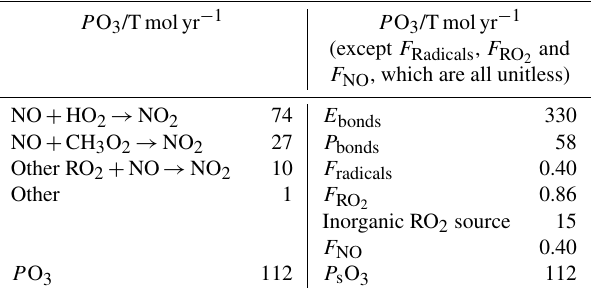
Table 1. Comparison of ozone production diagnostics for GEOS- Chem base simulation. Standard model P O 3 diagnostics (left col- umn) show reactions responsible for NO to NO 2 conversions but provide little process-level information. The new P s O 3 (right) pro- vides increased information on the processes controlling O 3 pro- duction within the